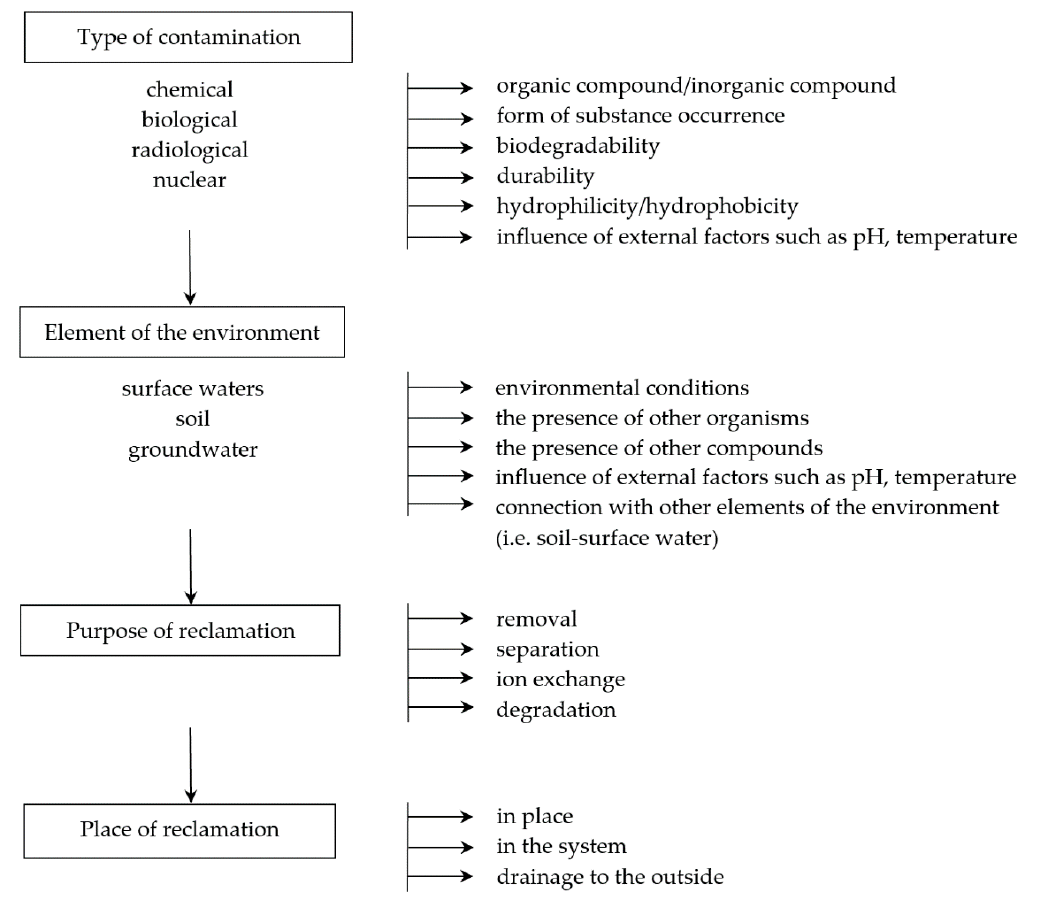
Figure 1. An example of a decision-making path necessary for the correct selection of the technique and type of membrane.